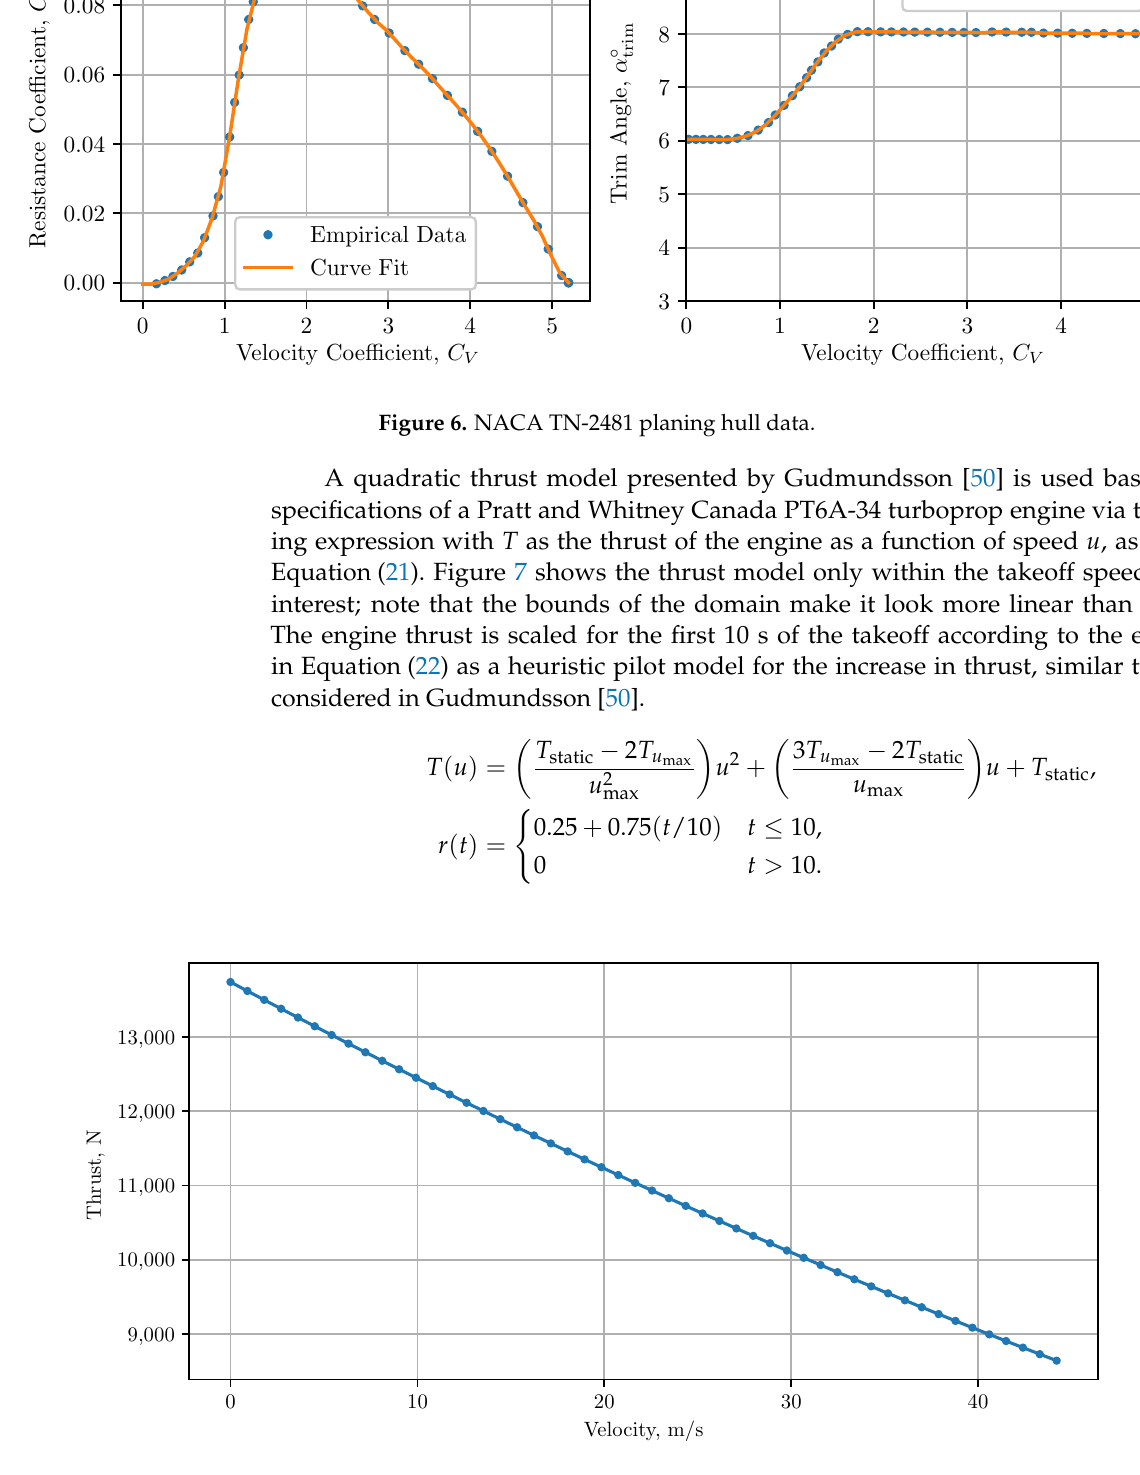
Figure 7. Thrust model as a function of speed, based on the specifications of a Pratt and Whitney Canada PT6A-34 turboprop